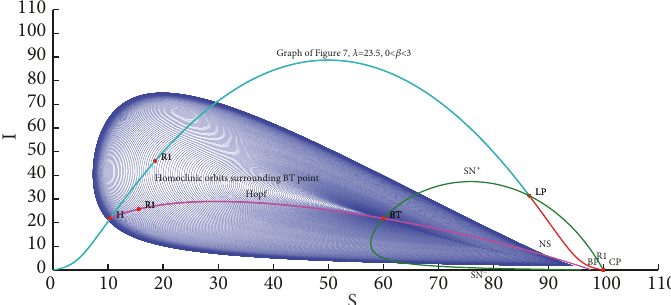
Figure 16: Movement of endemic equilibria as 𝛽 and 𝜆 vary along the bifurcation curves near the BT point.